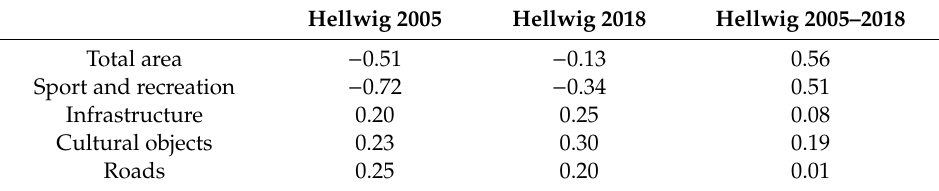
Figure 9. Change in the social development classes in the period from 2005–2018 compared to the area of land transferred for various purposes. Data for communes. Pearson correlation coefficient values obtained for communes are included in Table 5. Table 5. Pearson correlation coefficient values for all analysis variants/communes.